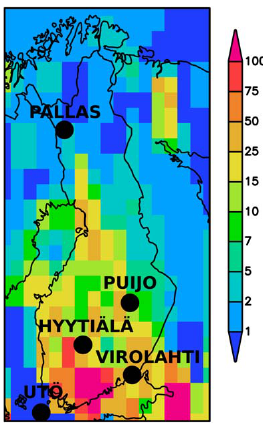
Fig. 2. The location of the measurement stations in Finland. The colour code represents the yearly black carbon emissions [mg/m 2